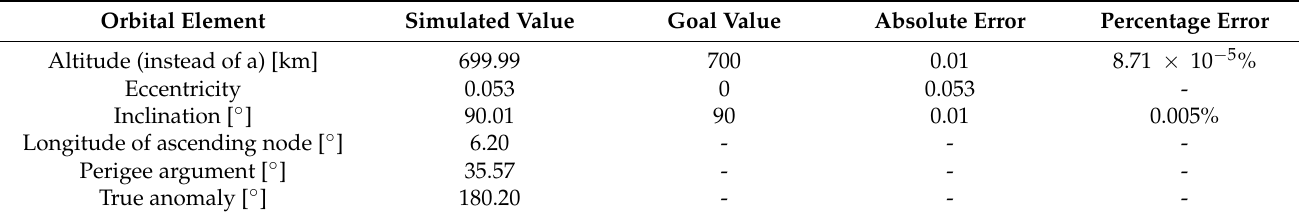
Table 10. Final orbital elements for the ascend trajectory.